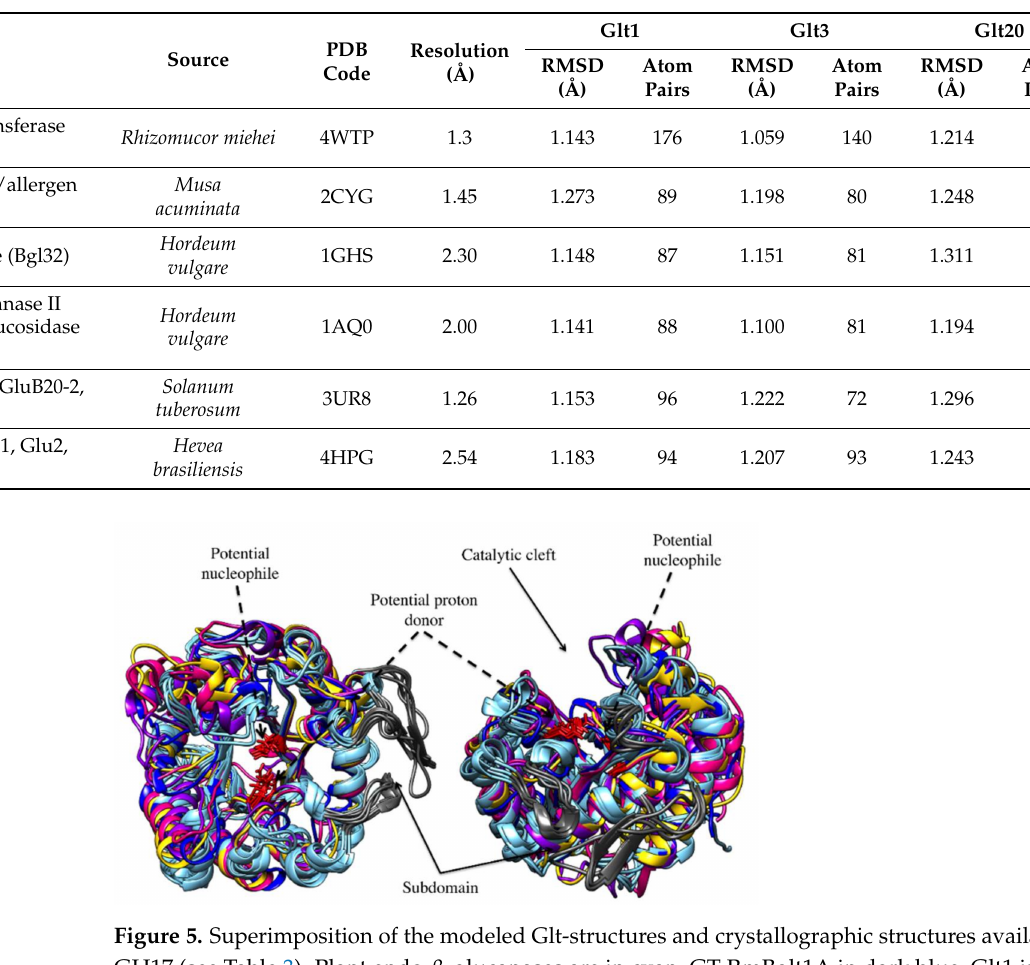
Table 3. Comparison of the refined models Glt1, Glt3, Glt7 and Glt20 with the crystallographic structures available in family GH17 (see Figure 5).